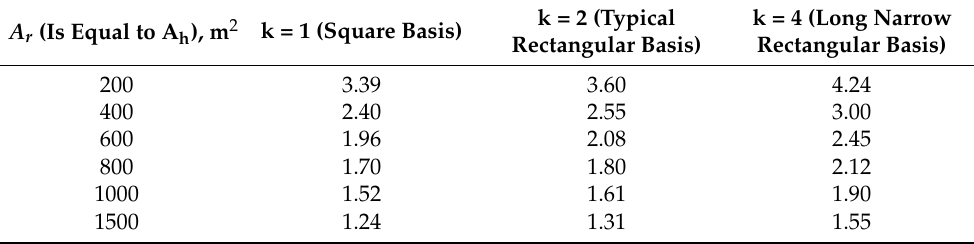
Table 2. Values of AR according to Equation (8) with typical value of h = 4 m for a three-story building ( n =